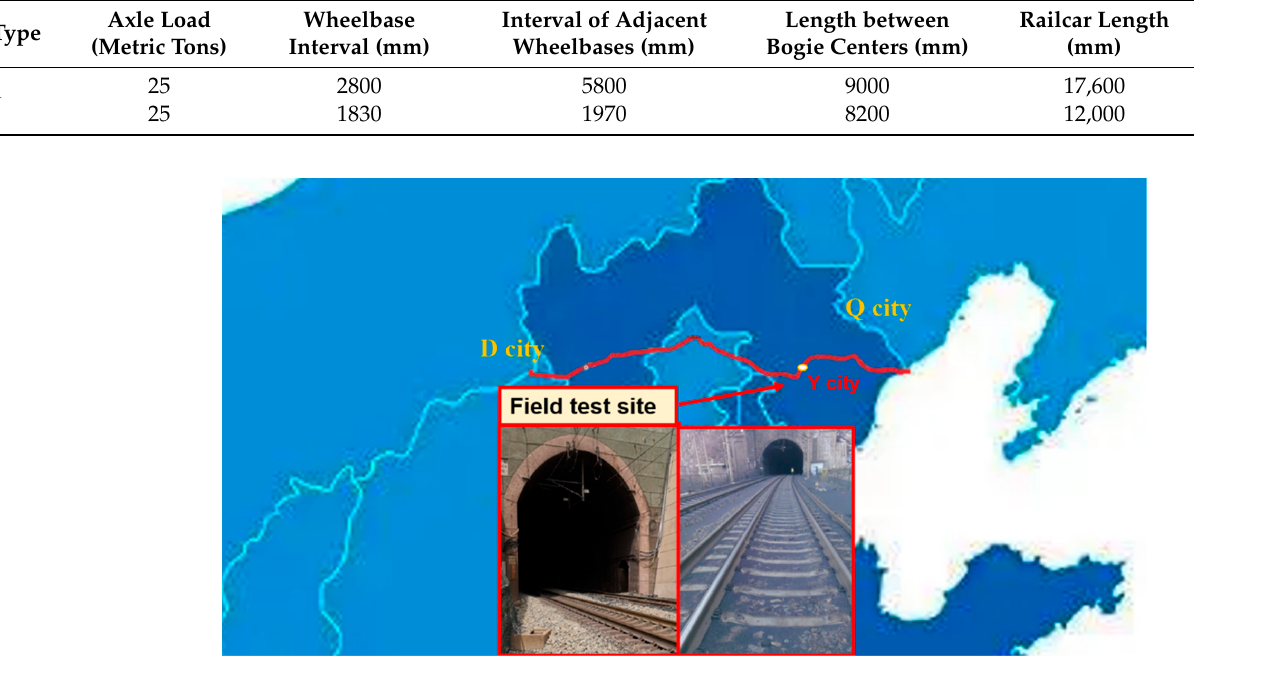
Figure 1. Location of field railway section studied.